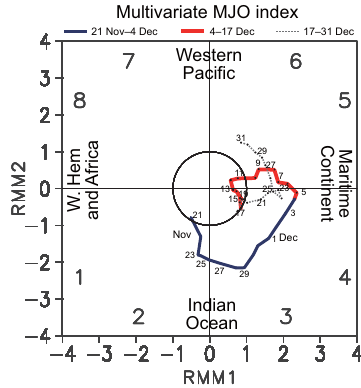
Figure 9. Phase diagram of the multivariate MJO index from 21 November to 31 December 2011. ber and ended on 8 December according to Gottschalck et al. (2013). The phase diagram of the multivariate MJO index of Wheeler and Hendon (2004), from 21 November to 31 De- cember 2011, is presented in Fig. 9. The period of tropical warming in the lower stratosphere from 4 to 17 December in Fig. 1 is indicated by solid red lines. The periods before and after are indicated by solid dark blue lines and dashed black lines respectively. Eastward propagation of the MJO is apparent during November 2011. The MJO suddenly weak- ens in the Maritime Continent region around 8 December. This disruption of the MJO follows the enhanced equatorial anomalous downwelling in the troposphere (Fig.